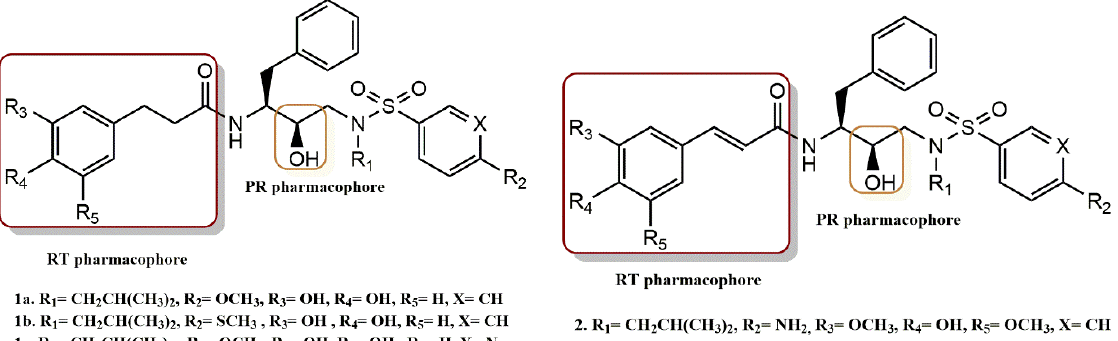
Figure 4. RT and PR pharmacophores of new active synthesized compounds 1a-c and 2 . In vitro assays were performed for all inhibitors using the FRET-based protease activity assay and HIV-1 RT activity. In addition, compounds 2 and 1b were tested in late and early-stage HIV-1 life cycle assays, with DRV and EFV serving as controls to further confirm the dual inhibitor targets. Inhibitor 1b showed an antiviral EC 50 of 2.31 µ M and 97% inhibition in late-stage HIV-1 at a concentration of 10 µ M and an EC 50 of 8.32 µ M and 68% inhibition in early-stage HIV-1. Inhibitor 2 showed an antiviral EC 50 value of 37.35 µ M and 30% inhibition in late-stage HIV-1 and an EC 50 of 68.02 µ M and 14% inhibition in early-stage